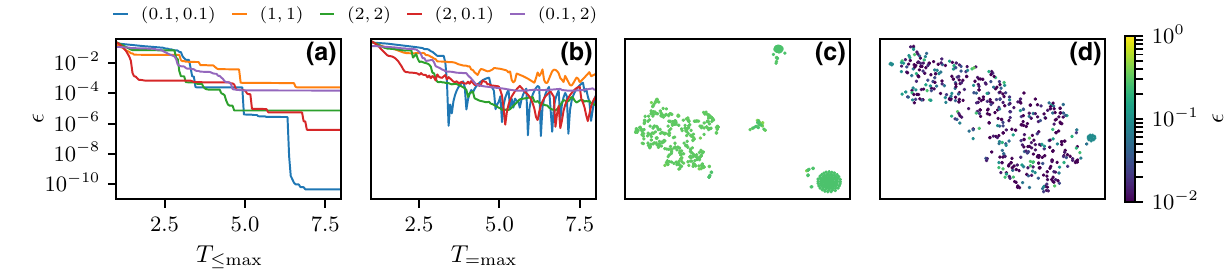
FIG. 5. Minimization landscape in the AFM Ising model. (a) Relative energy (cid:3) versus T ≤ max for different points in S . (b) Relative energy (cid:3) versus T = max for different points in S . (c) The t-SNE graph for 500 random angle samples taken at ( h x , h z ) = ( 1, 1 ) and T = max = 1. (d) The t-SNE graph for 500 random angle samples taken at ( h x , h z ) = ( 1, 1 ) and T = max = 8. All data are for system size N = 6 and p = 3. The color scale of (c) and (d) represents the value of (cid:3)